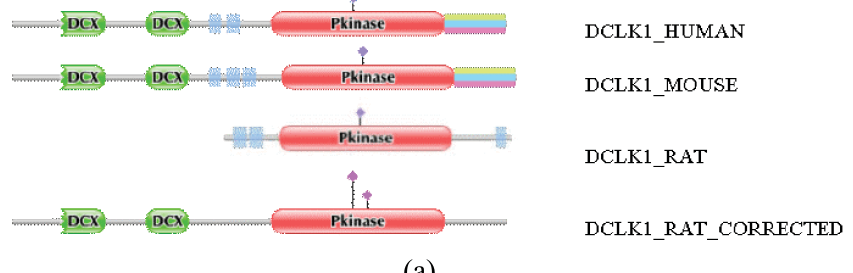
Figure S2. Correction of the sequence of rat DCLK1_RAT by the FixPred